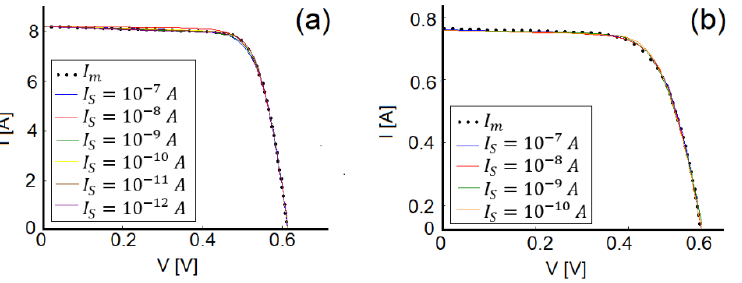
Figure 2. The I-V characteristics of two commercial PV modules: ( a ) M1 and ( b ) M2 estimated with SDA for different values of the diode saturation current I S (values set a priori) superimposed on the measured I-V characteristics.